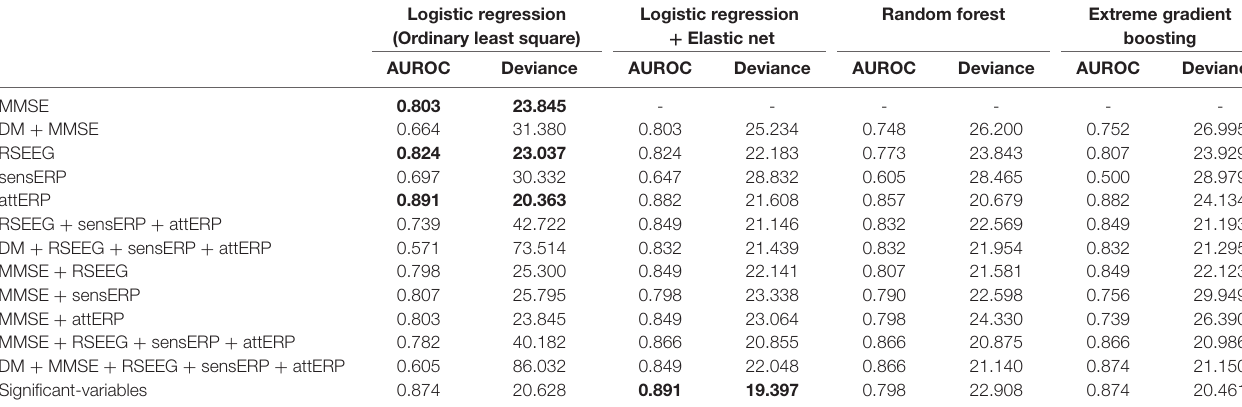
TABLE 3 | Evaluation results of prediction models according to type of data and classification model. Logistic regression Logistic regression Random forest Extreme gradient (Ordinary least